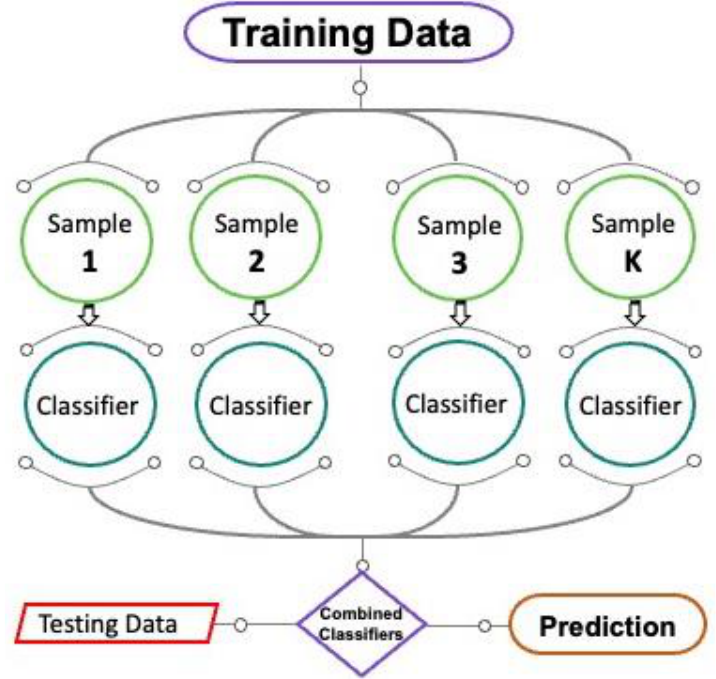
Figure 7. Bagging algorithm flow chart indicating the step-by-step procedure of prediction.